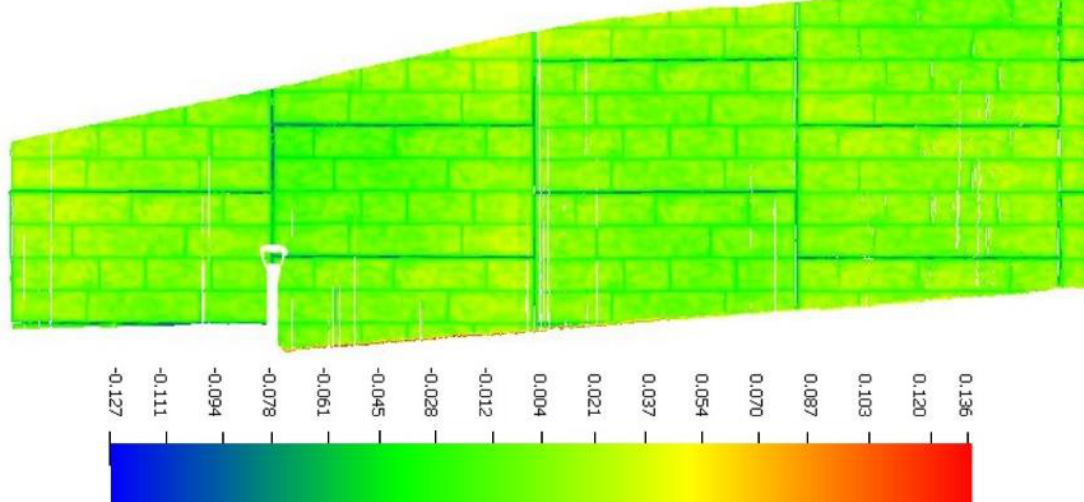
Figure 14. Normal distance map for a given face illustrating the fact that joints among the panels could be distinguished through their normal distance from the best fitting plane to that face (units for the values along the scale bar are in meters).